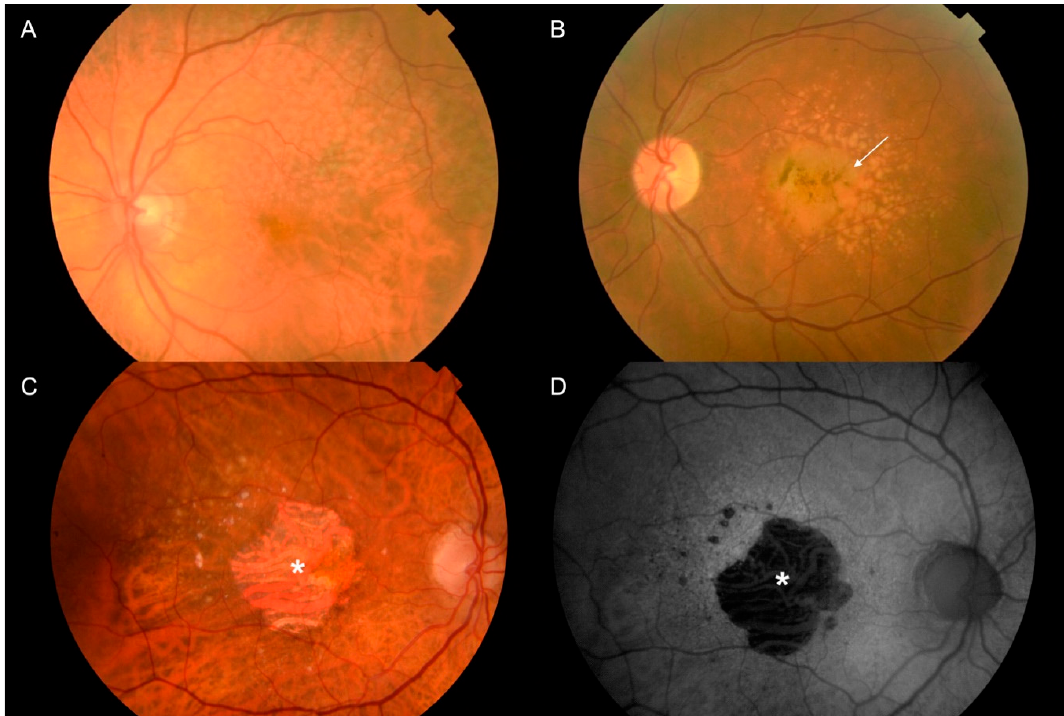
Figure 1. Age-related macular degeneration (AMD) is an eye disease affecting the macula, a central region in the retina. Individuals affected by AMD in its advanced stage may experience a profound loss of central vision. ( A,B ) Color pictures of retina with changes typical for early stages of AMD, typified by the presence of numerous large drusen, more or less confluent, and associated (or not) with retinal pigment epithelium (RPE) abnormalities ( arrow ). ( C,D ) Color and autofluorescence (AF) pictures of fundus for retina with changes typical for dry AMD. ( C ) The advanced form of dry AMD is typified by the presence of central geographic atrophy (GA) showing a sharply demarcated atrophic lesion of the outer retina, resulting from the loss of photoreceptors, RPE, and choriocapillaris ( asterisk ). ( D ) GA areas typically appear as dark patches in fundus AF images, and can be clearly delineated ( asterisk ).